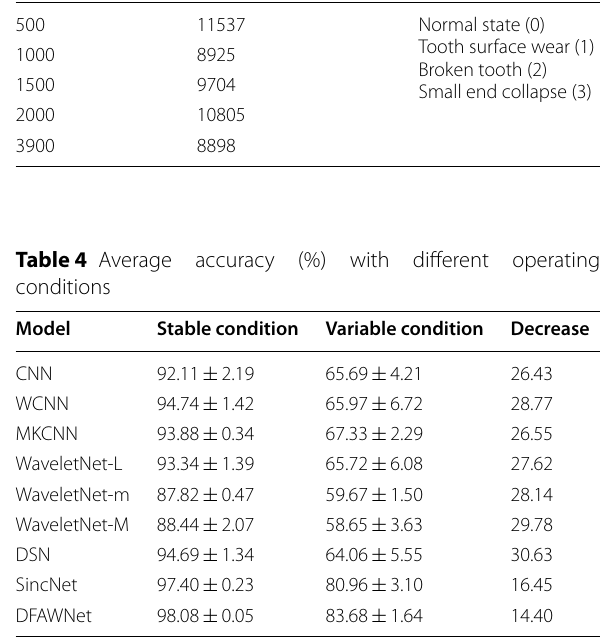
Table 3 Aeroengine bevel gear dataset Rotating speed (r/ min)